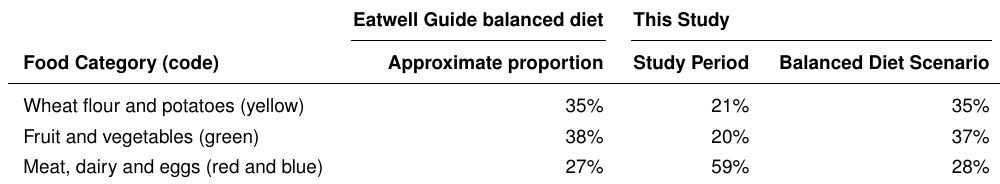
Table 5. Comparison of proportions of food categories between the Eatwell Guide’s balanced diet and this study. Eatwell Guide balanced diet